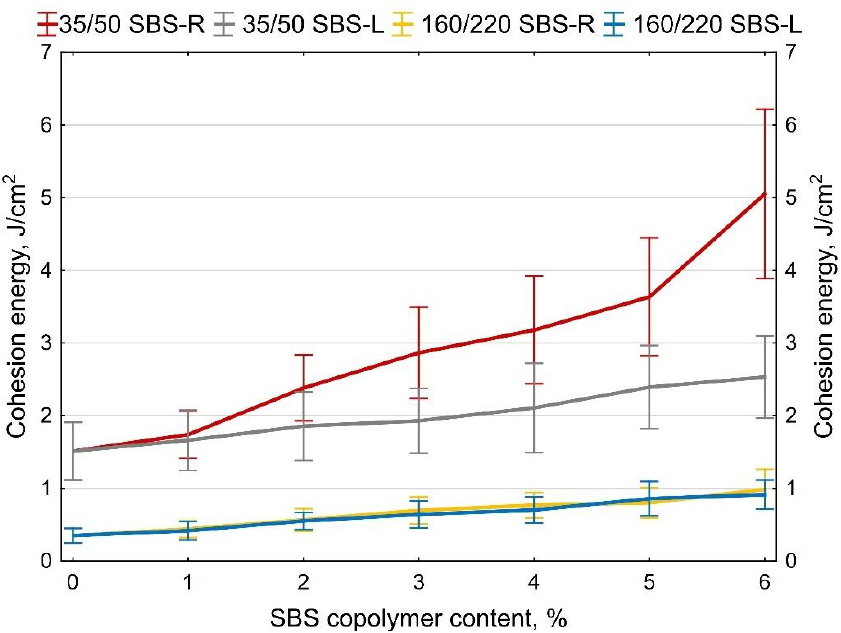
Figure 18. Cohesion energy of bitumen during stretching in Area II (as per Figure 2b), error bars show a 95% confidence interval for the mean.